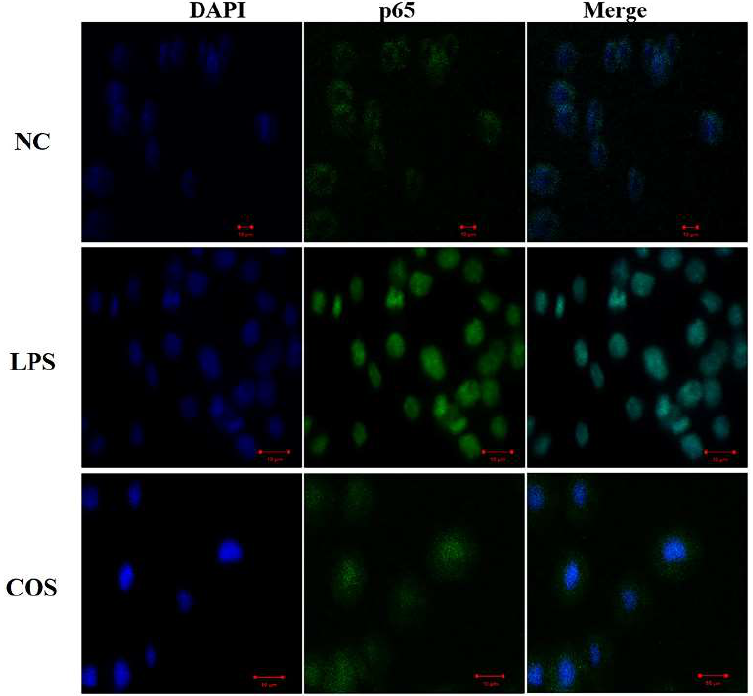
Figure 7. The immunofluorescent staining assay was used to analyze the nuclear translocation of NF- κ B in RAW264.7 cells. NF- κ B was stained with rabbit anti-NF- κ B p65 IgG, with FITC-conjugated goat anti-rabbit IgG as secondary antibody (green). Nuclei were stained with DAPI (blue). Measuring bar 10 μm.